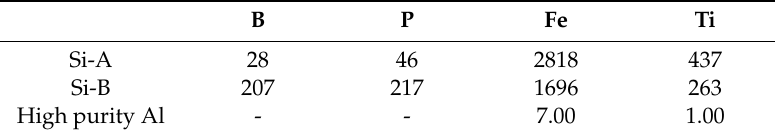
Figure 1. Schematic diagram of experimental equipment. Table 1. Contents of impurities in MG-Si and high purity Al